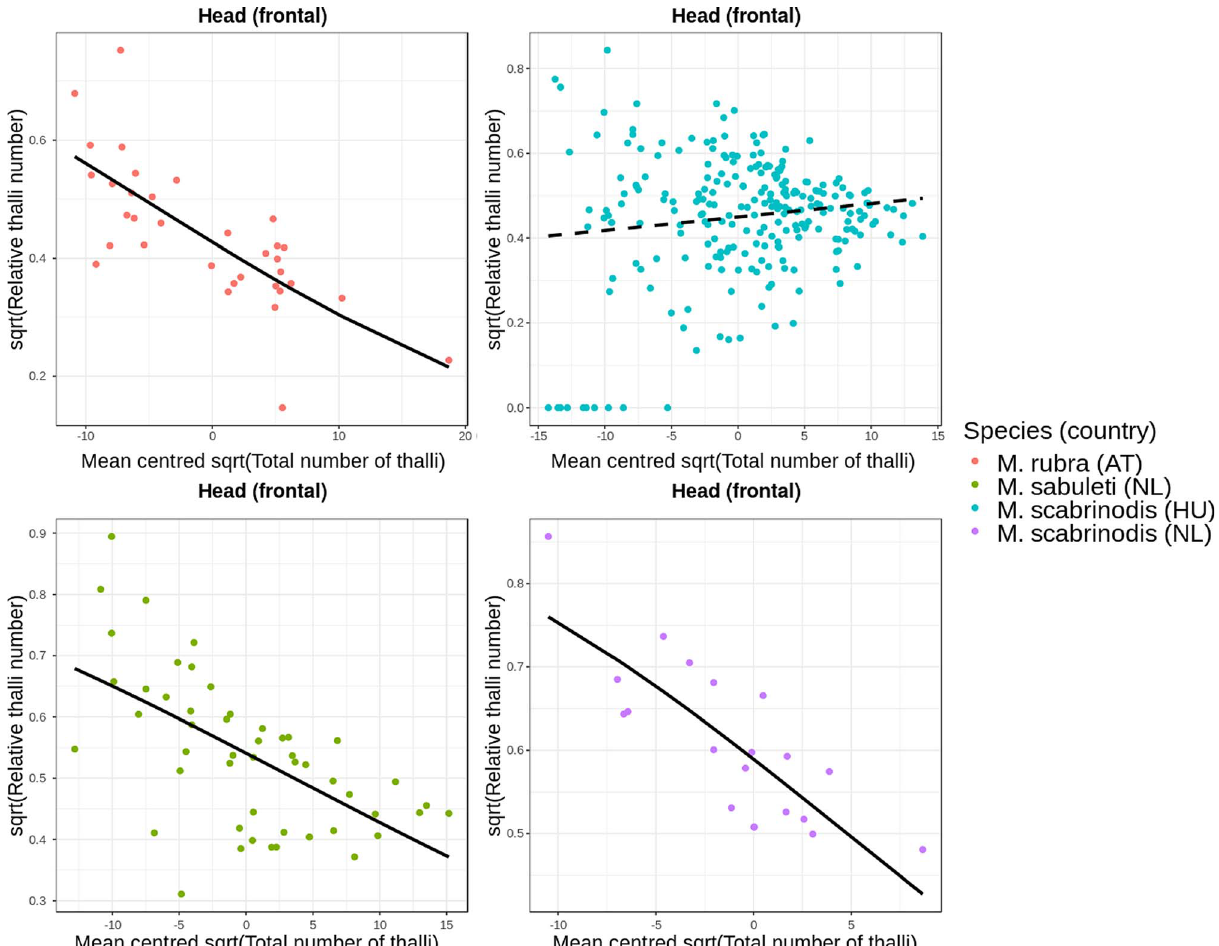
Figure 7. Association between total number of thalli and relative number of thalli on the frontal side of the head ( n = 354). Black curves are regression lines from the fi tted model: solid and dashed lines represent signi fi cant and non-signi fi cant associations,